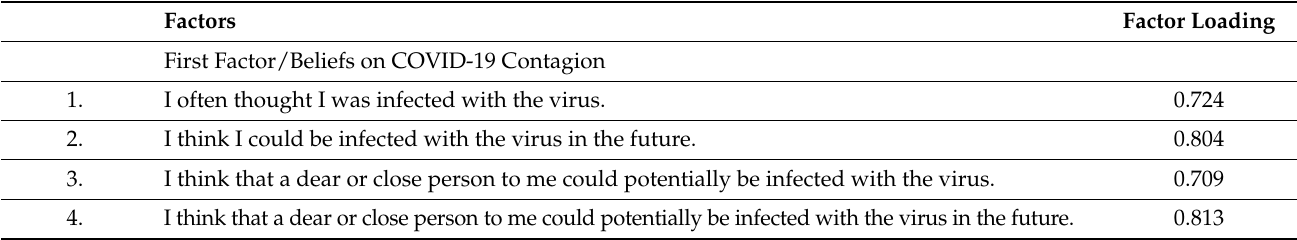
Table 1. Pattern matrix of the PCA for the Fear of COVID-19